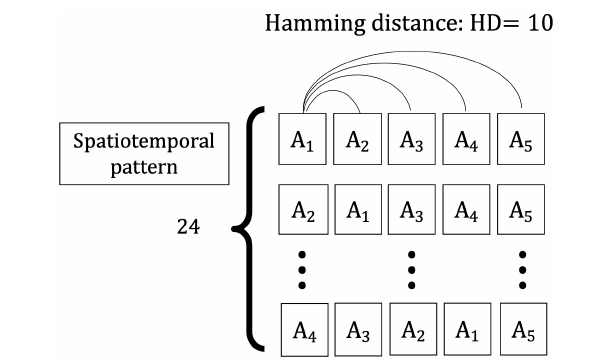
FIGURE 3 | Spatiotemporal patterns applied to the single-layer network. A sample of the spatial frame, i.e., A 1 , consisting of N = 120 elements. Spatiotemporal patterns of contextual inputs, { X ( t 1 ), X ( t 2 ), ... , X ( t 5 ) } , each pattern has a temporal sequence of 5 spatial patterns { A 1 , A 2 , A 3 , A 4 , A 5 } . The Hamming distance between every two spatial patterns is 10